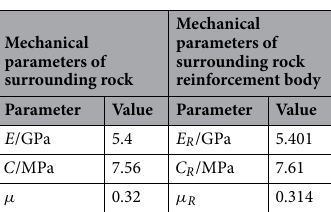
Table 2. Changes in physical and mechanical parameters of surrounding rock of roadway roof.